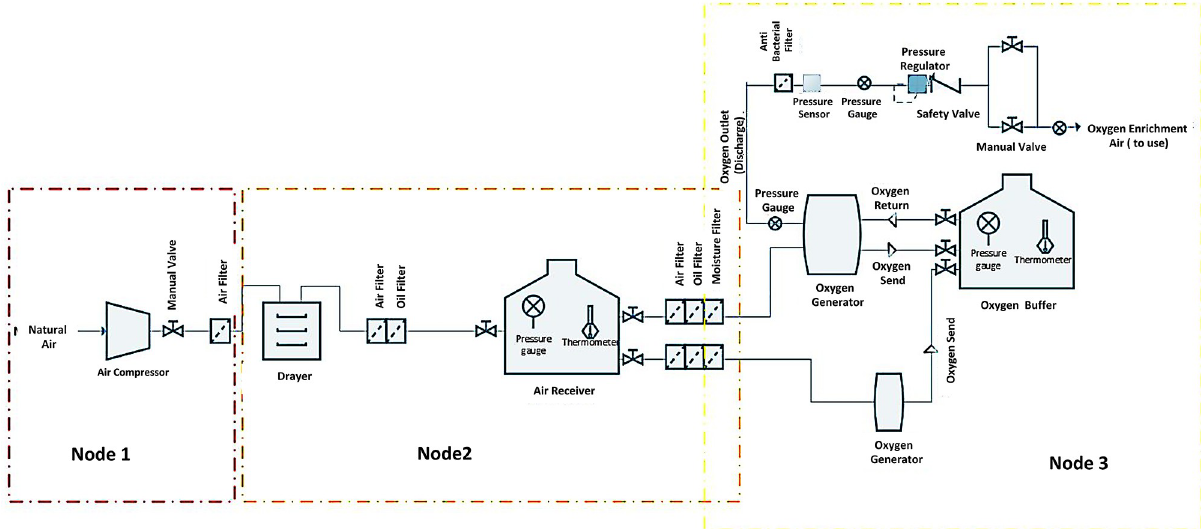
Fig 7. Flowchart of hospital concentration system and node made based on HAZOP method.